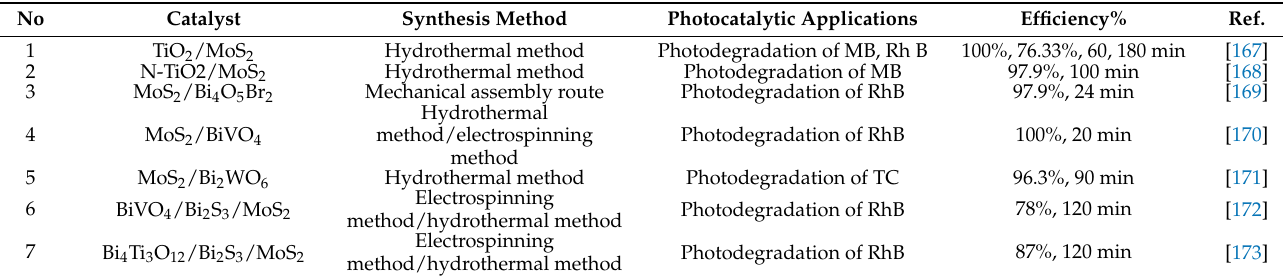
Table 2. List of MoS 2 -based semiconductor